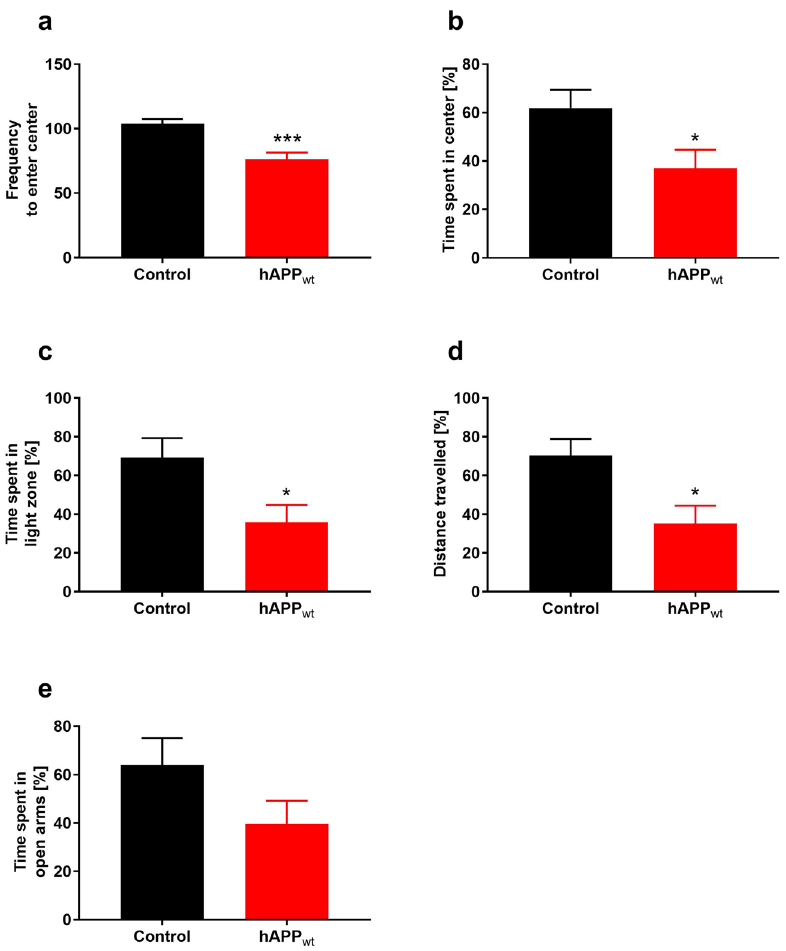
Figure 3. Assessment of anxiety-like behavior in 6 month old male hAPP wt mice and corresponding controls. ( a ) Frequency to enter the center of the open field (OF) was compared between hAPP wt (n = 16) and controls (n = 12). ( b ) Percentage of time spent in the center of the OF. ( c ) Percentage of time spent in the light zone of the light–dark test setup (LDT). ( d ) Distance travelled in the light zone of the LDT (n = 10 for hAPP wt and n = 7 for controls). ( e ) Percentage of time spent in the open arms of the elevated plus maze (EPM) (n = 10 for hAPP wt and n = 7 for controls). (Values are means ± SEM; *P ≤ 0.05, ***P ≤ 0.001, two-tailed unpaired t-test for a and two- tailed unpaired t-test with Welch’s correction for b–e